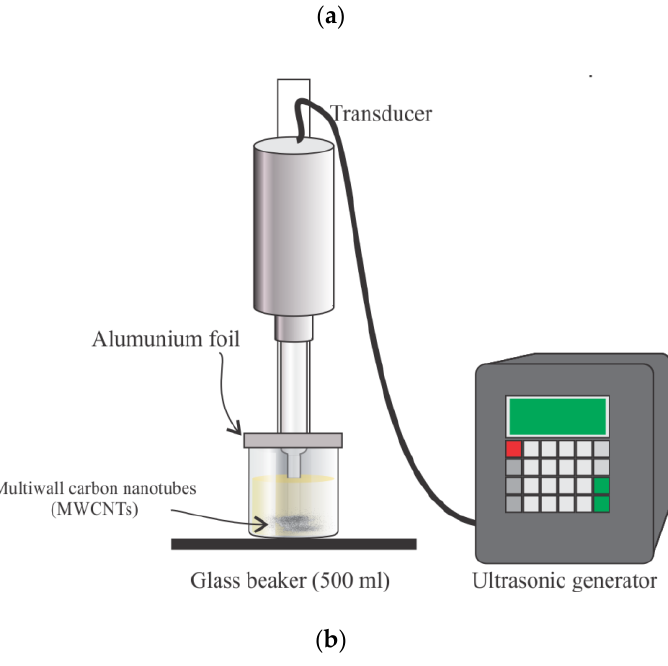
Figure 1. ( a ). Biodiesel production using ultrasound equipment system; ( b ) ultrasound homogenization device.